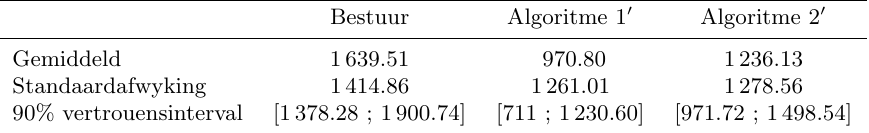
Tabel 1: Gemiddelde verliese (in rand) met D ( P i , t ) eksponensieel en α = x w .